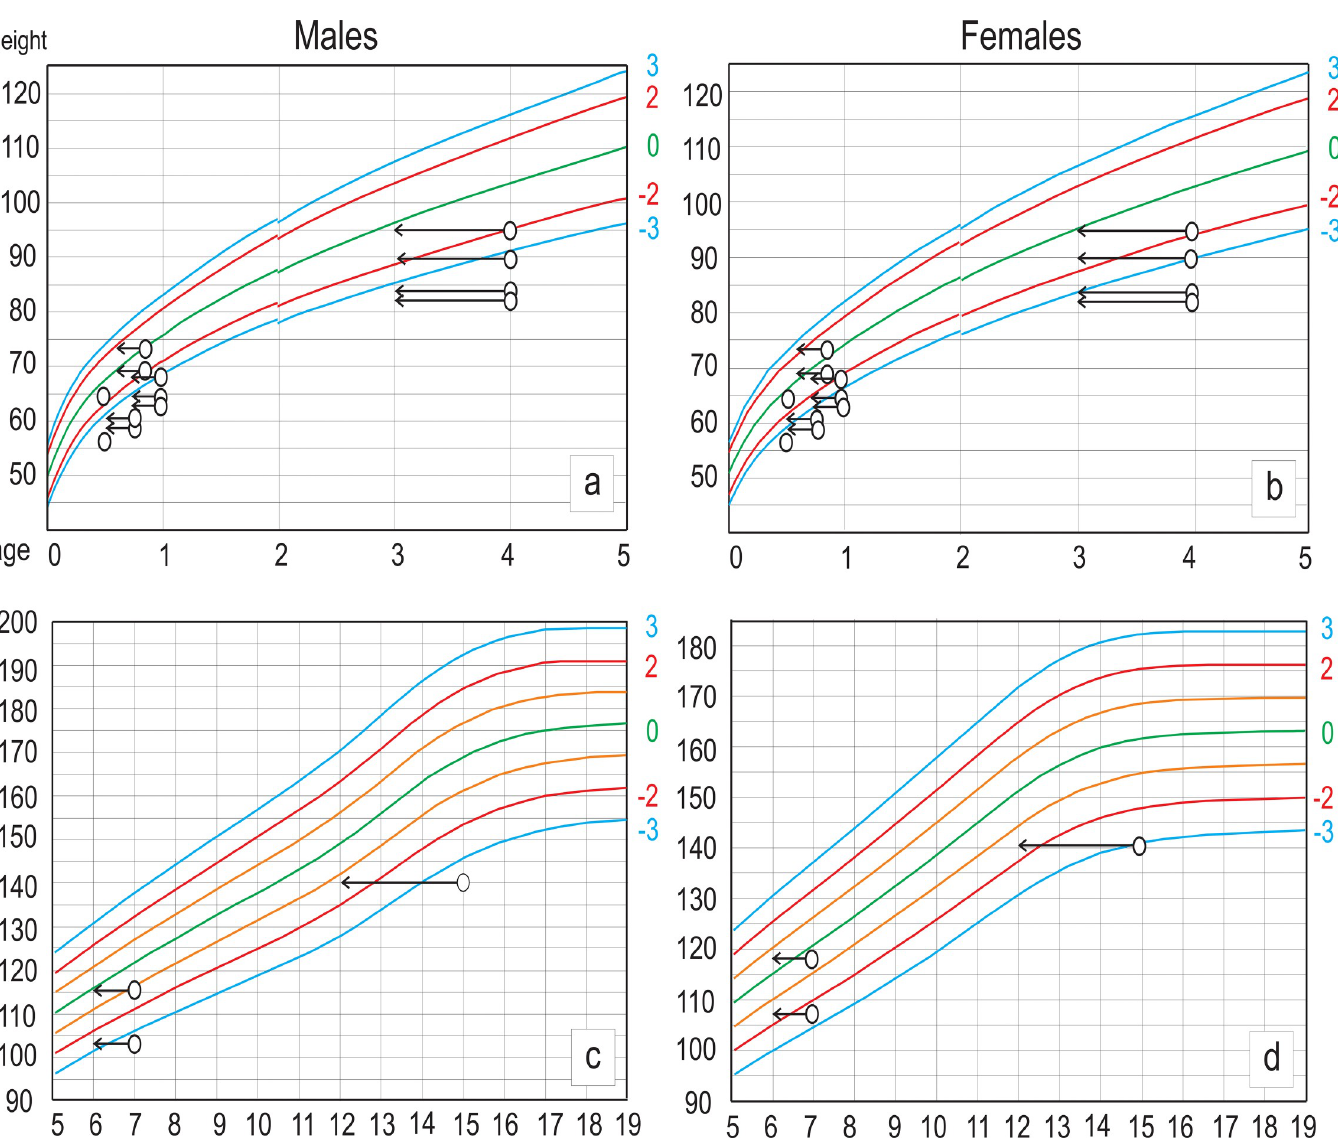
Fig 3. Height-for-age in individuals from Jabuticabeira II in the WHO developmental charts. a) Male individuals aged 0–5 years; b) Female individuals aged 0–5 years; c) Male individuals aged 5–19 years; d) Female individuals aged 5–19 years. Points show height-for-age when age-at-death was estimated according to Ubelaker [90] dental chart. Arrows show height-for-age when age-at-death was estimated using the Gaither [91] chart. Red line: 2 σ ; Blue line: 3 σ .